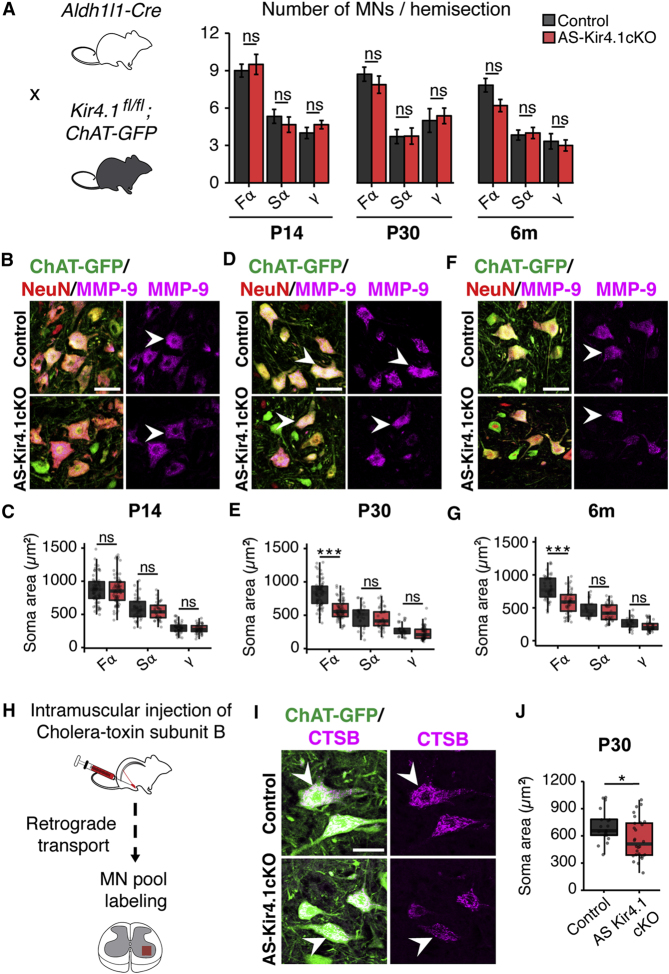
AS Kir4.1 Is Required for Maintenance of FαMN Size(A) Left: breeding scheme. AS-Kir4.1cKO and cre-negative control animals were bred with ChAT-GFP mice for MN visualization. Right: total FαMN (ChAT+/MMP-9+/NeuN+), SαMN (ChAT+/MMP-9−/NeuN+), and γMN (ChAT+/MMP-9−/NeuN−) numbers are equivalent in AS-Kir4.1cKO and cre-negative control mice at the indicated ages (n = 3 mice/group, mean ± SEM, lumbar spinal cord, Welch’s t test).(B, D, and F) Representative images of lumbar MNs at P14 (B), P30 (D), and 6 months (F). Arrowheads denote example FαMNs (scale bar, 50 μm).(C, E, and G) Quantification of MN size at P14 (C), P30 (E), and 6 months (G) (n = 3 mice/group, >100 MN counts/animal, boxplot, Mann-Whitney test).(H) Schematic of retrograde labeling of MN pools using intramuscular injection of fluorescent cholera toxin subunit B (CTSB) in the tibialis anterior (TA) muscle.(I) Representative images of retrograde-labeled ventral horn MNs in AS-Kir4.1cKO and cre-negative control mice. Arrowheads denote example putative FαMNs (scale bar, 50 μm).(J) Quantification of ChAT-GFP+CTSB+ MN soma area from (G) (n = 3 mice/group, >50 MN counts/animal, boxplot, Mann-Whitney test). ∗p < 0.05, ∗∗∗p < 0.001. Edges of boxplots denote interquartile range (25th–75th percentile) with whiskers denoting 1.5 times the interquartile range and black line denoting the median value.